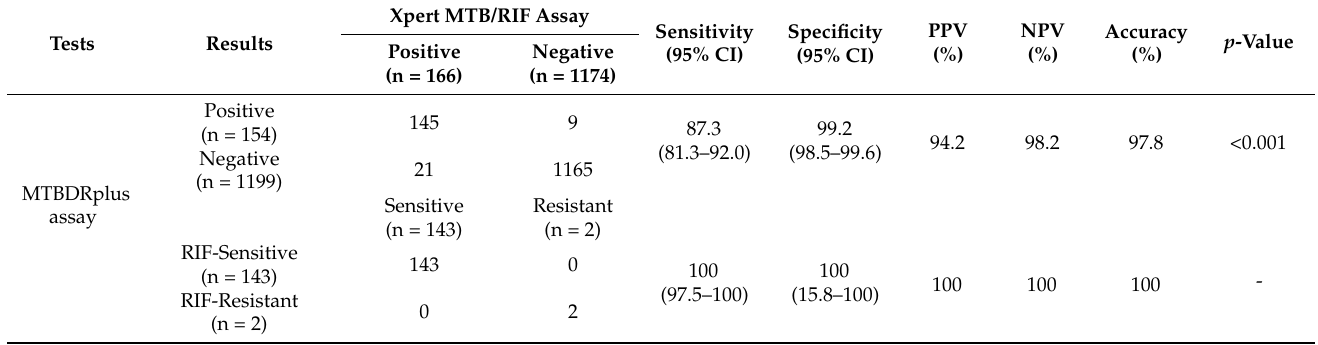
Table 4. Comparison of Xpert MTB/RIF and GenoType MTBDRplus for the detection of Rifampicin